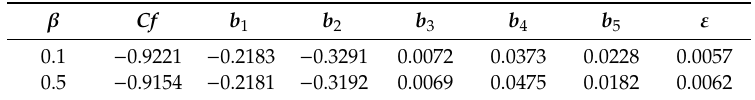
Table 5. The values of error bound ε and coe ffi cients of multiple quadratic regression for estimated Cf x Re 1/2 x due to variations in M and K 1 are obtained as.